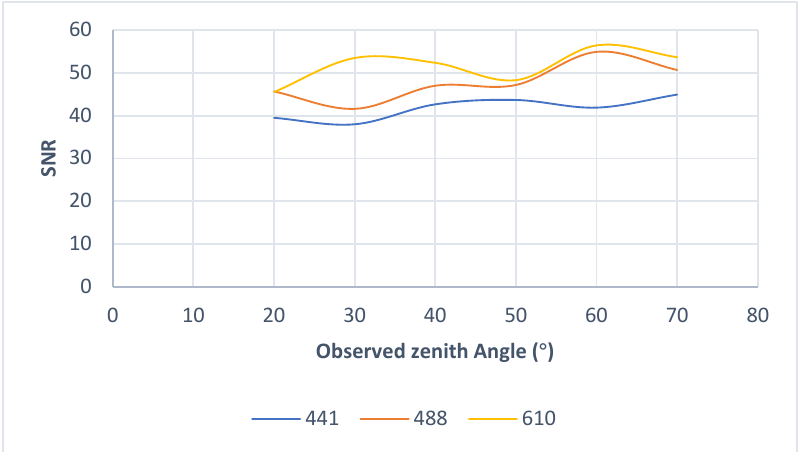
Figure 5. SNR curve with observed zenith angle. Three bands of 441 nm, 488 nm and 610 nm were selected to plot the change curve of SNR with observed zenith angle.